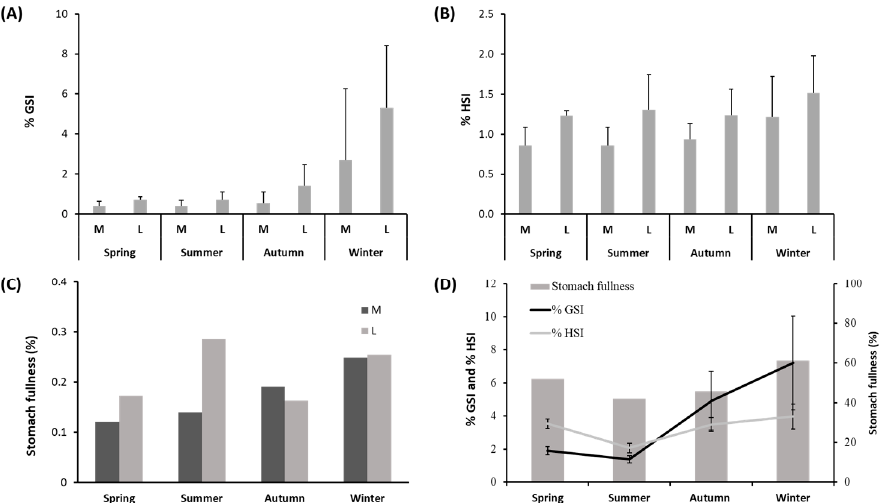
Figure 3. ( A ) %GSI, ( B ) %HSI, and ( C ) stomach fullness measured seasonally in medium–(M)- and Sea for a study of their diet. ( D ) %GSI, %HSI, and stomach fullness measured seasonally in female specimens of Solea solea